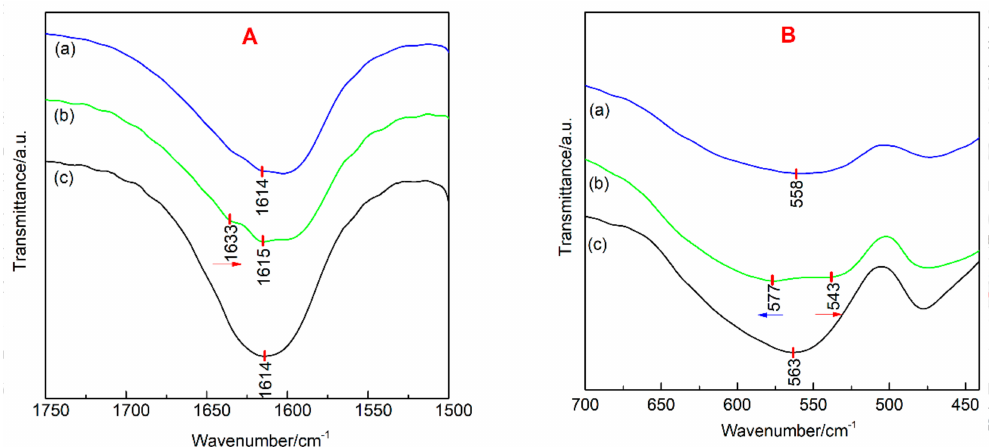
Figure 6. FTIR spectra local amplification results of samples (A and B are enlarged view of Figure 5.). ( a ) Undoped α -Fe 2 O 3 sample; ( b ) Ce-doped α -Fe 2 O 3 sample; ( c ) Bayer α -Fe 2 O 3